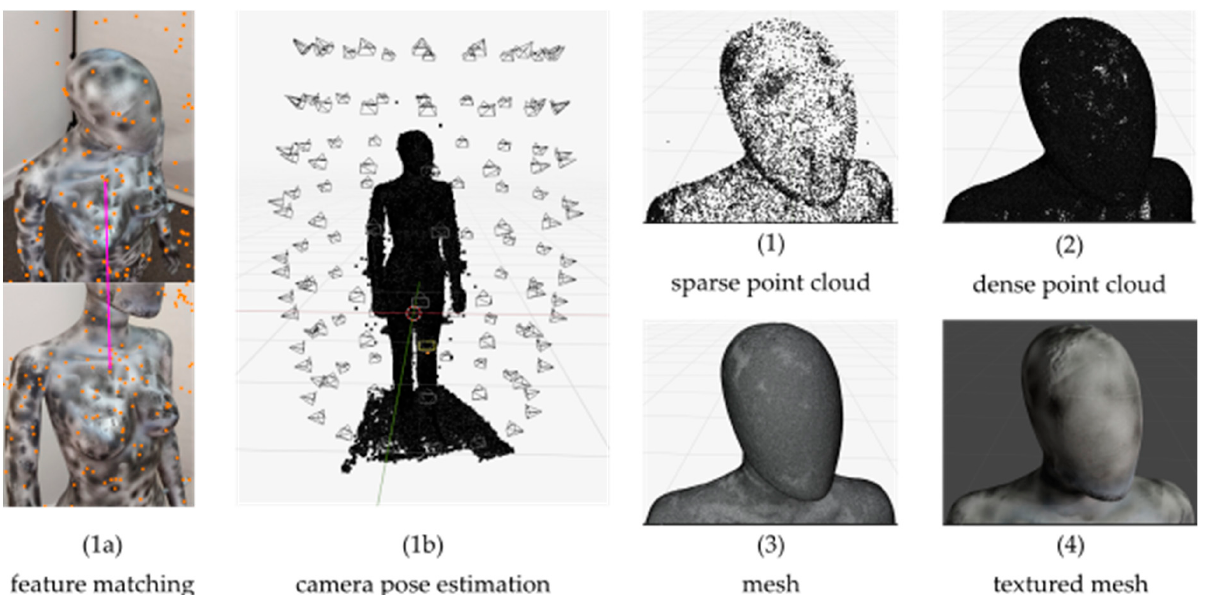
Figure 1. Illustration of stages of the reconstruction process using photogrammetry technique.